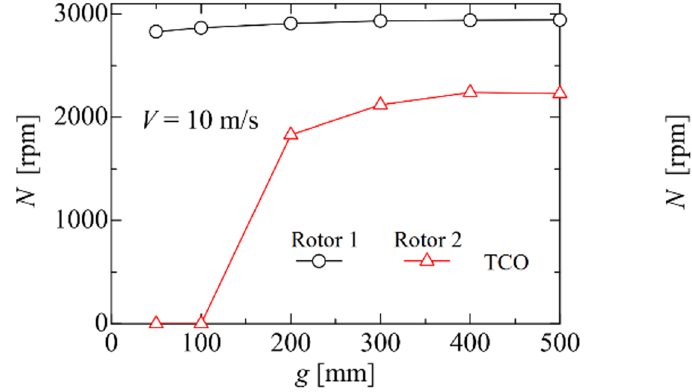
Figure 9. Experimental setup of a trio of 3D ‐ printed VAWT models with a gap of g / D = 1 in the 3IR configuration at θ = 120° (2COB).